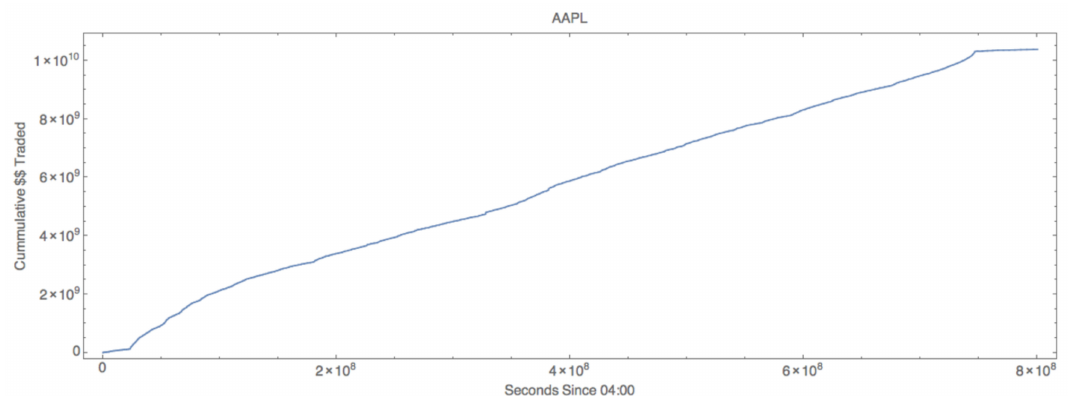
Figure 7. Cumulative dollars traded in Apple stock on 11 August 2015 summed each second from 04:00 until 20:00.